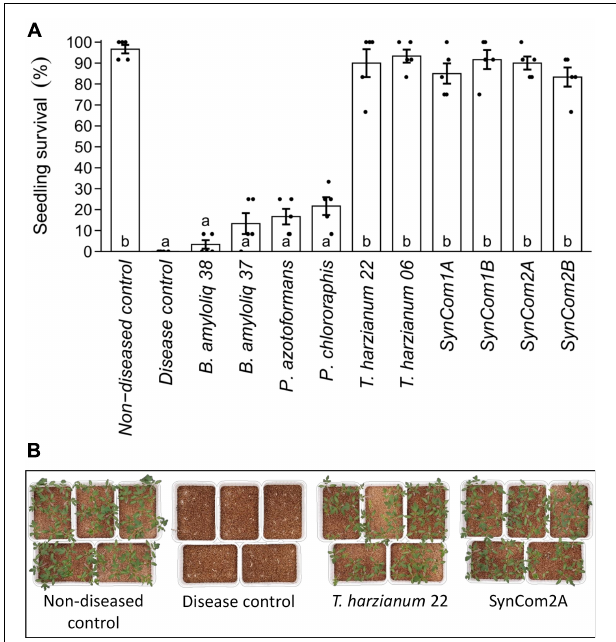
FIGURE 1 | Effect of microbial inoculation on disease caused by the soil-borne pathogen Fusarium oxysporum. (A) Survival of tomato plants after 15 days of growth in F. oxysporum -infected soil. Seeds were either water-inoculated (“disease control”) or inoculated with the individual or consortia treatments (see Supplementary Table 2 ). A “non-diseased control” was also included, where water-inoculated seeds were sown in soil without F. oxysporum . Single strains were inoculated at 1 × 10 7 cfu/plant and the consortia were inoculated at the same concentration for each microorganism (SynCom1A, SynCom2A) or at 1 × 10 7 cfu/plant total microbial concentration (SynCom1B, SynCom2B). Bars represent predicted mean ± SE of the probability of seedling survival based on a generalized linear model with binomial distribution and logit link function. Black dots represent raw data points. Treatments not sharing a letter in common are significantly different based on the Tukey honestly significant difference (HSD) test ( p < 0.05, n = 5). (B) Survival of plant seedlings in F. oxysporum -infected soil. Pictures illustrate plant survival in non-diseased and disease control, Trichoderma harzianum, and SynCom2A treatments.